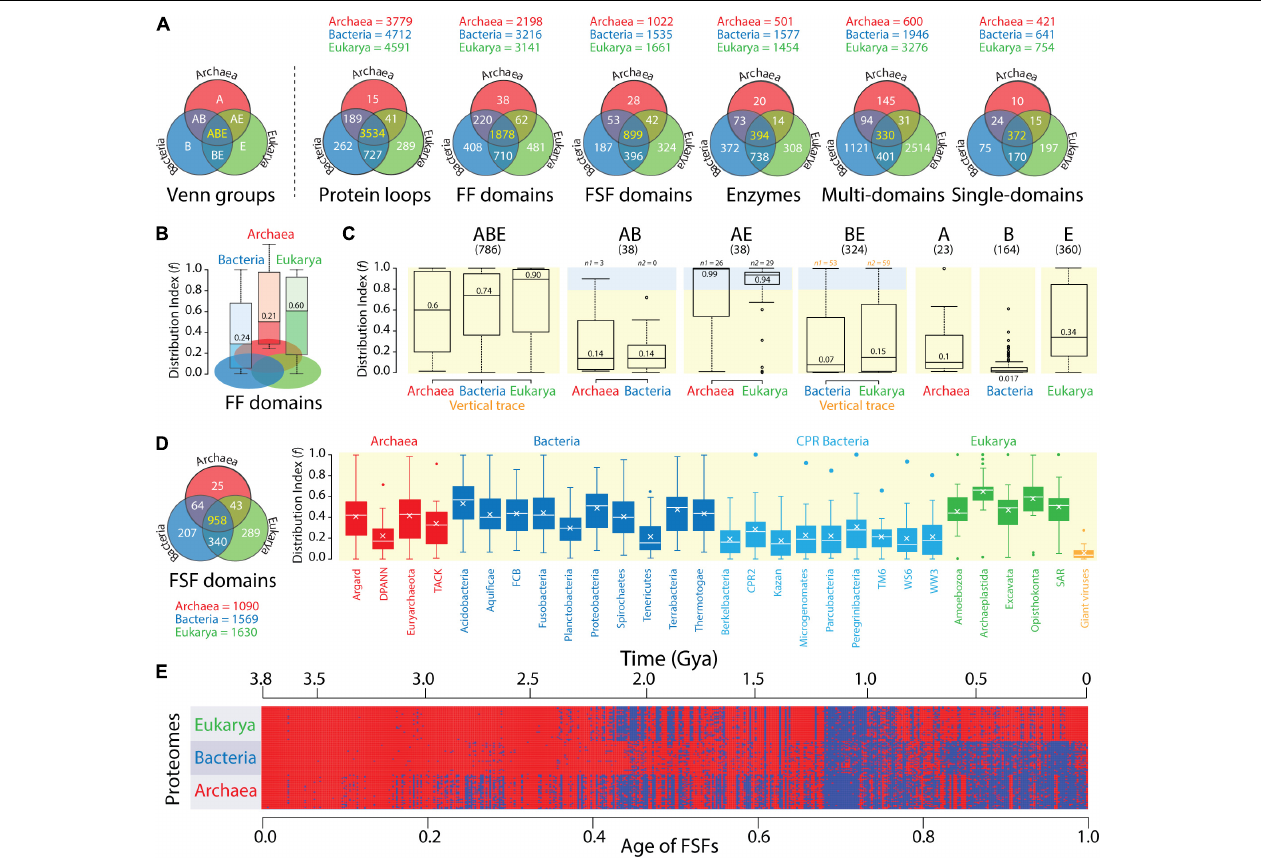
FIGURE 4 | The compressed protein vocabularies of microbial domains. (A) Venn diagrams of molecular trait distributions in superkingdoms show vocabulary compression in Archaea. The Venn diagrams describe a censuses of protein loops (8,127 proteomes; Mughal and Caetano-Anollés, unpublished), structural domains defined at fold family (FF) and superfamily (FSF) levels of SCOP structural classification (8,127 proteomes; Mughal et al., 2020), enzyme domains (989 proteomes; Mughal and Caetano-Anollés, 2019), and multidomain and single-domain architectures of proteins in proteomes (266 proteomes; Wang and